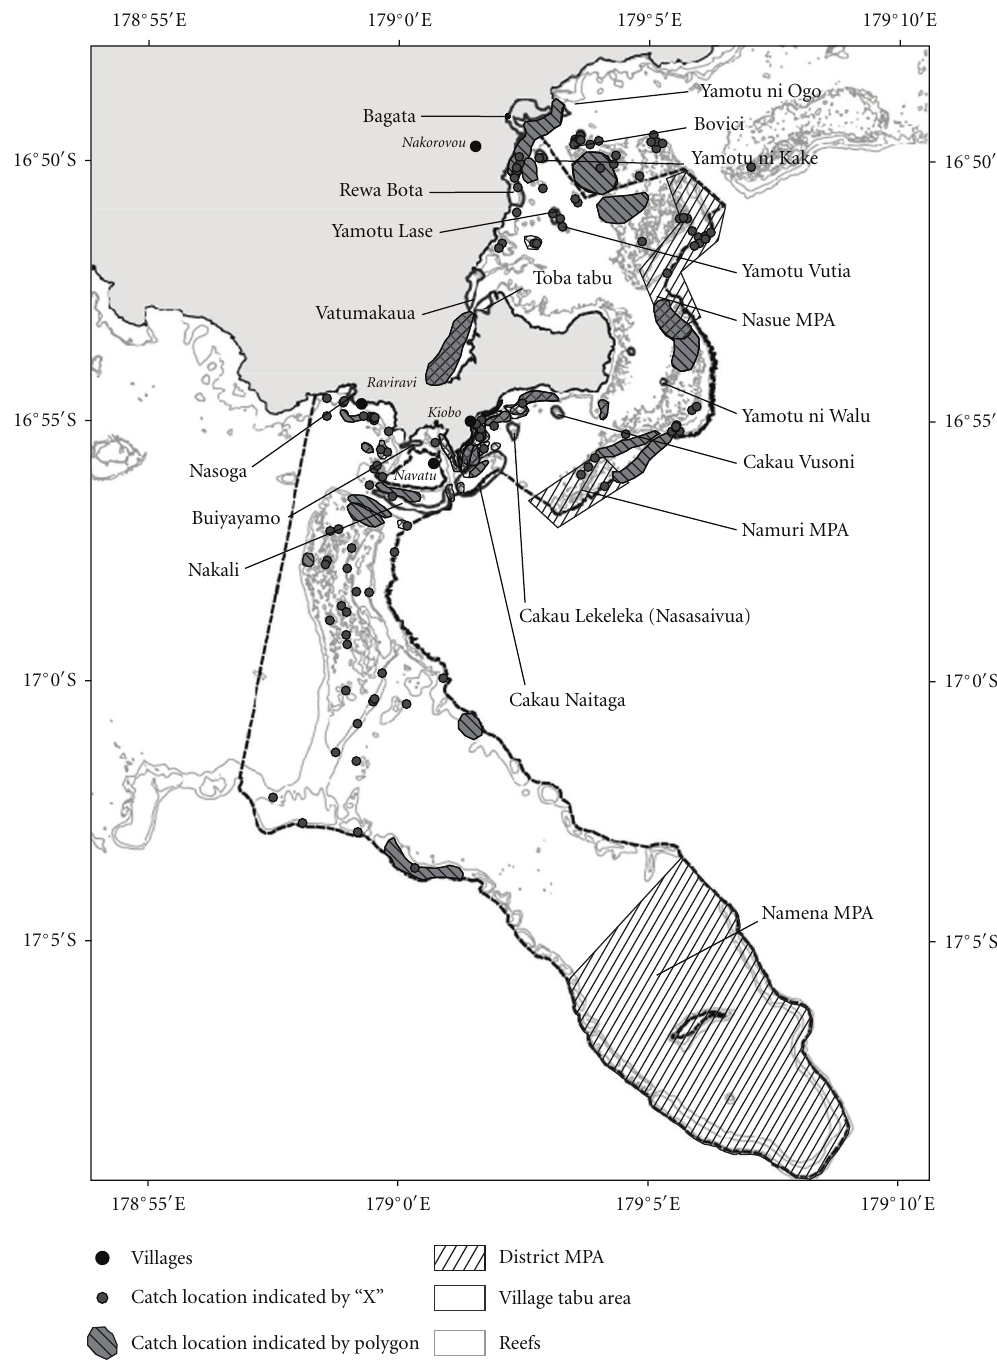
Figure 4: Fishing locations (grey circles and shaded grey polygons) recorded by Kubulau fishers from Raviravi, Navatu, Kiobo, and Nakorovou fishers between May 2008 and June 2009. CPUE locations, District MPAs, and tabu areas are